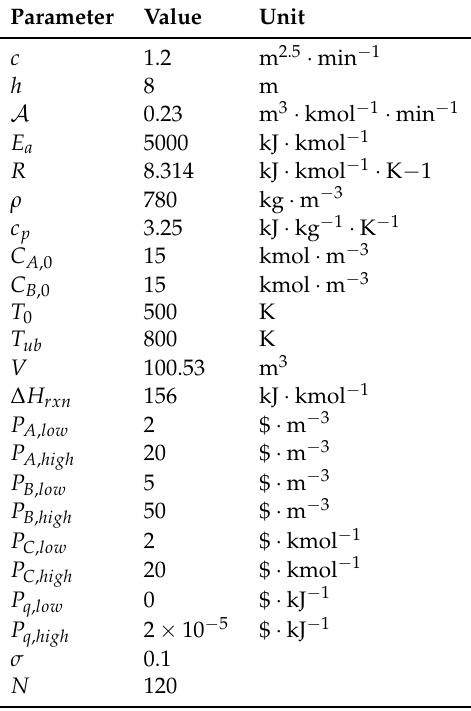
Table 1. Model simulation